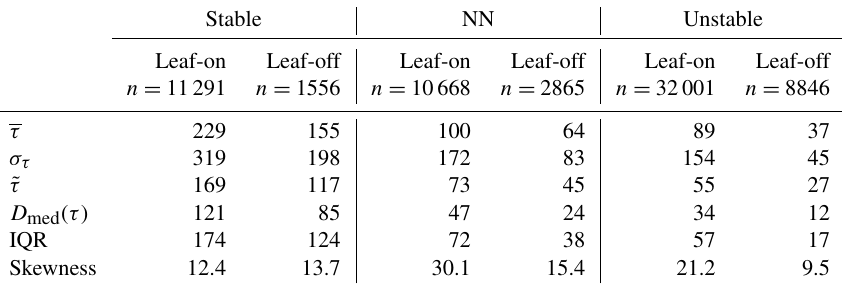
Table 2. Descriptive statistics of τ values (Sect. 2.3) for the leaf-on and leaf-off periods binned into three stability regimes. All values in seconds rather than normalised units (other than the skewness, which has no units). The symbols τ , σ τ , ˜ τ , and D med ( τ ) denote the mean, standard deviation, median, and median absolute deviation, respectively (see Sects. 2.4 and 3.2 for an overview of these statistics). Stable NN Unstable Leaf-on Leaf-off Leaf-on Leaf-off